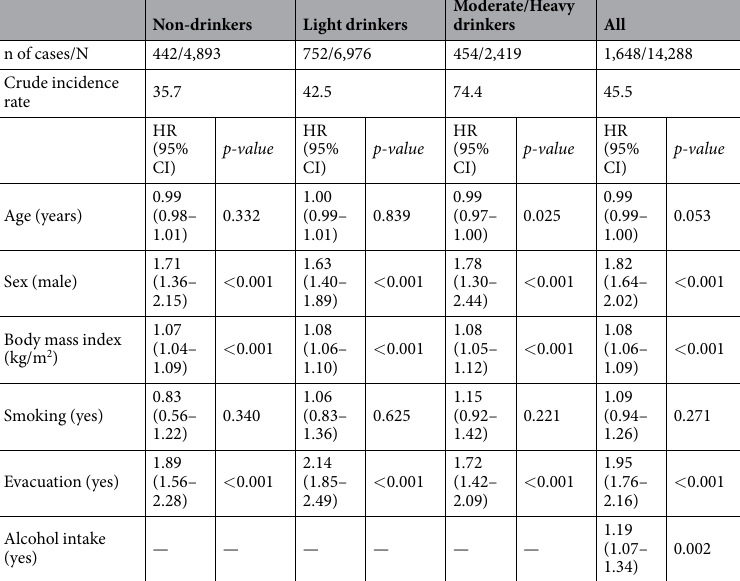
Moderate/Heavy drinkers All